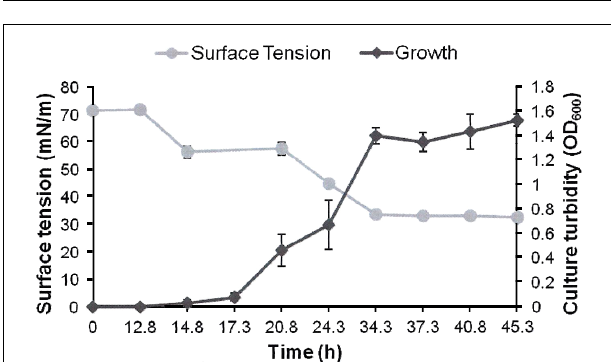
FIGURE 1 | Growth and biosurfactants production byAK6U in sulfur-free minimal medium containing MgSO 4 as a sole sulfur source and glucose as a carbon source. Biosurfactants production was monitored by measuring the surface tension of the cell-free culture supernatants. Data are averages of measurements from three cultures ± SE.